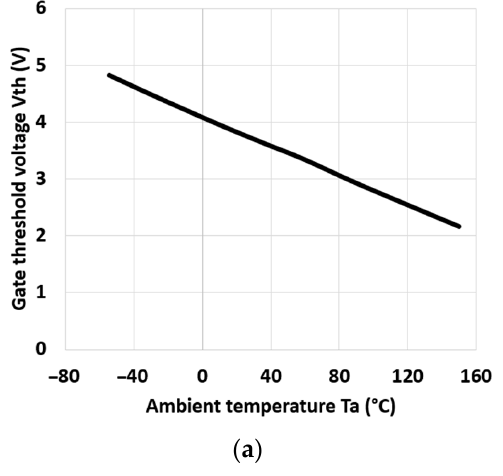
Figure 4. Threshold voltage: ( a ) Si MOSFET (Toshiba TK22V65X5) [44]; ( b ) SiC MOSFET (Microsemi MSC015SMA070B) [45].